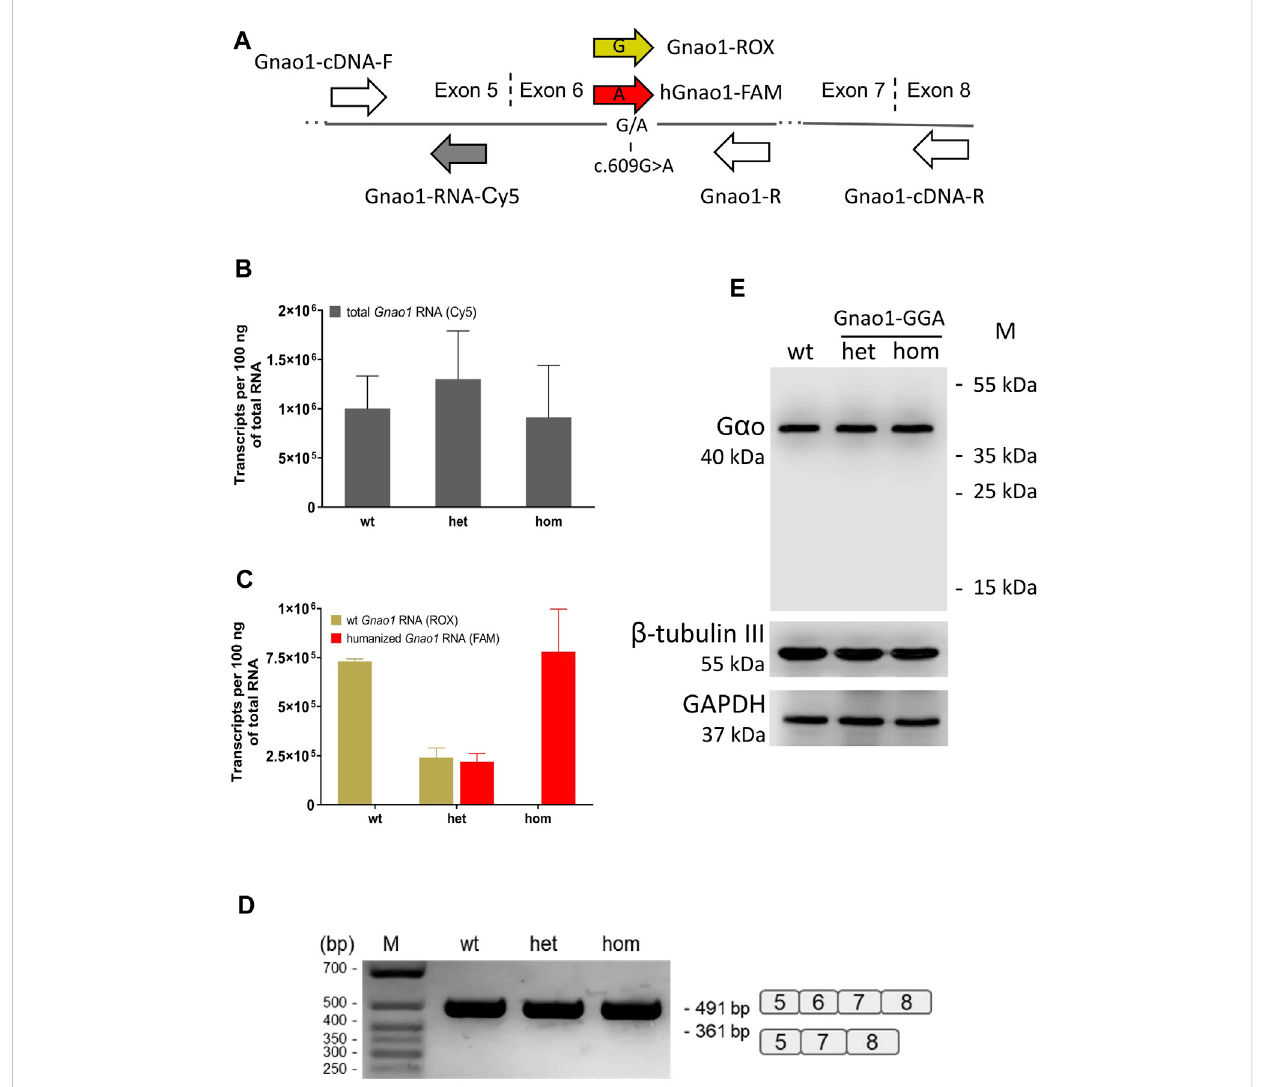
FIGURE 3 Gnao1 mRNA and protein expression in the brain of Gnao1-GGA mice. (A) Schematically shown the position of primers and probes along Gnao1 mRNA used for allelic qPCR and exon 6 splicing analysis (see Materials and Methods ). The vertical dash lines mark the exon junctions. (B) The total amount of Gnao1 transcripts in the brains of F2 littermates was assessed by qPCR (Mean ± SD; n = 3 animals per genotype). (C) RNA expression of wild- type (wt) and “ humanized ” Gnao1 in the brain assessed by allele-speci fi c qPCR of F2 littermates with the wt, heterozygous (het), and homozygous (hom) Gnao1-GGA genotype (Mean ± SD; n = 3). (D) RT-PCR products with primers Gnao1-cDNA-F and -R spanning exons 5 to 8 from representative F2 littermates were analyzed in an agarose gel. A schematic representation of the spliced variants is given to the right of the gel. (E) Protein brain